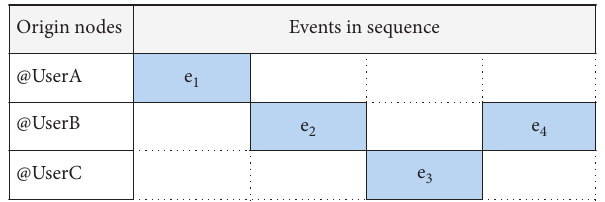
Figure 5: A sample of the input data—event sequences from Figure 3 grouped by origin nodes. Source: own